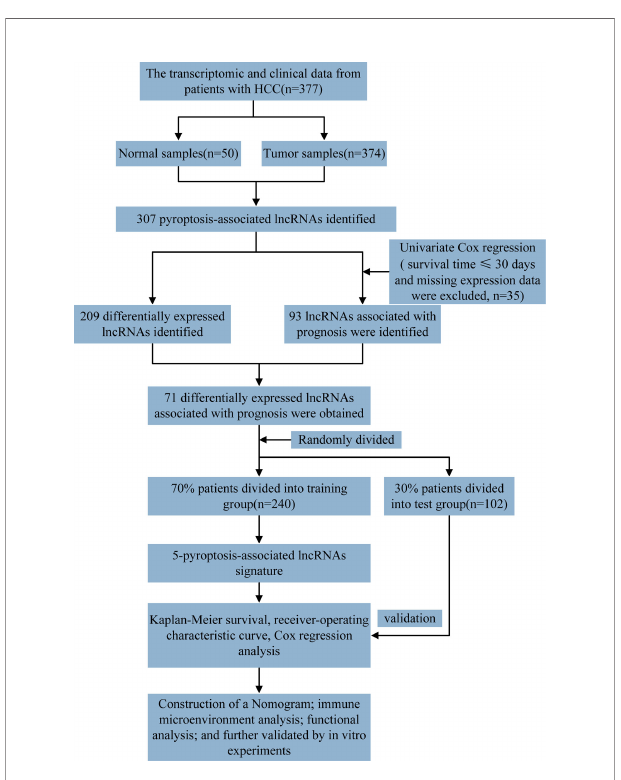
FIGURE 1 | Representation of the overall fl owchart of the given